Question: Sum up the contents of this chart in one sentence.
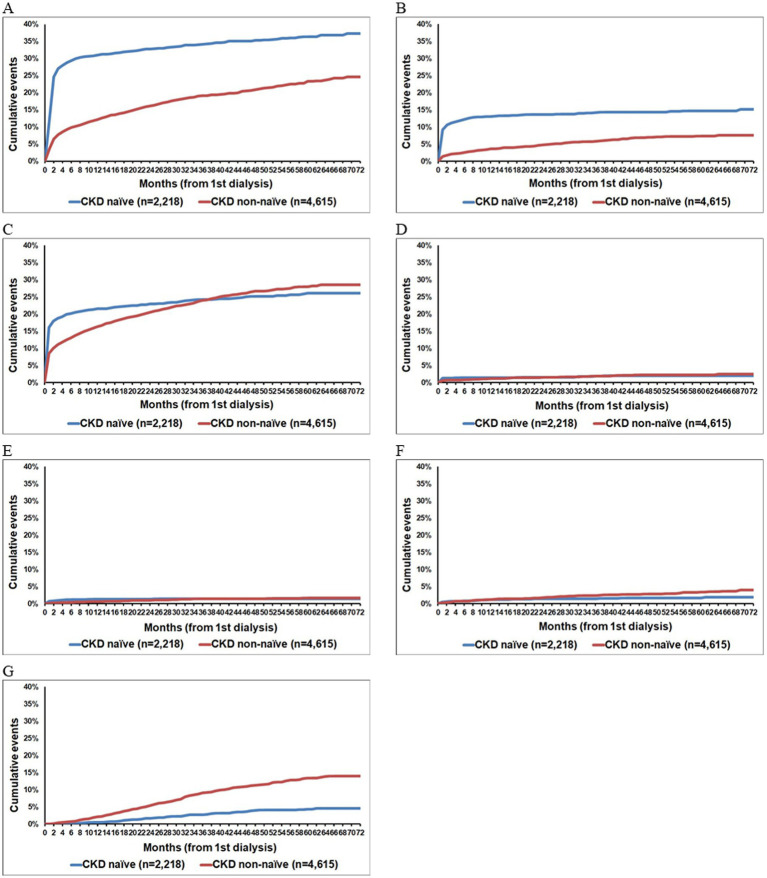
Answer: Cumulative incidence of the primary endpoints from the time-to-first event analyses in the CKD naive arm ( n = 2,218) and the CKD non-naive arm ( n = 4,615) during the 72-month follow-up after the first dialysis. Primary endpoints were (A) all-cause mortality, (B) cancer, (C) hospitalization for heart failure, (D) acute myocardial infarction with percutaneous coronary intervention, (E) stroke (with CT/MR), (F) lower limb amputation, and (G) kidney transplantation. Data are unadjusted for the different propensity score subclassification hazards (no differences in hazards and statistics provided).